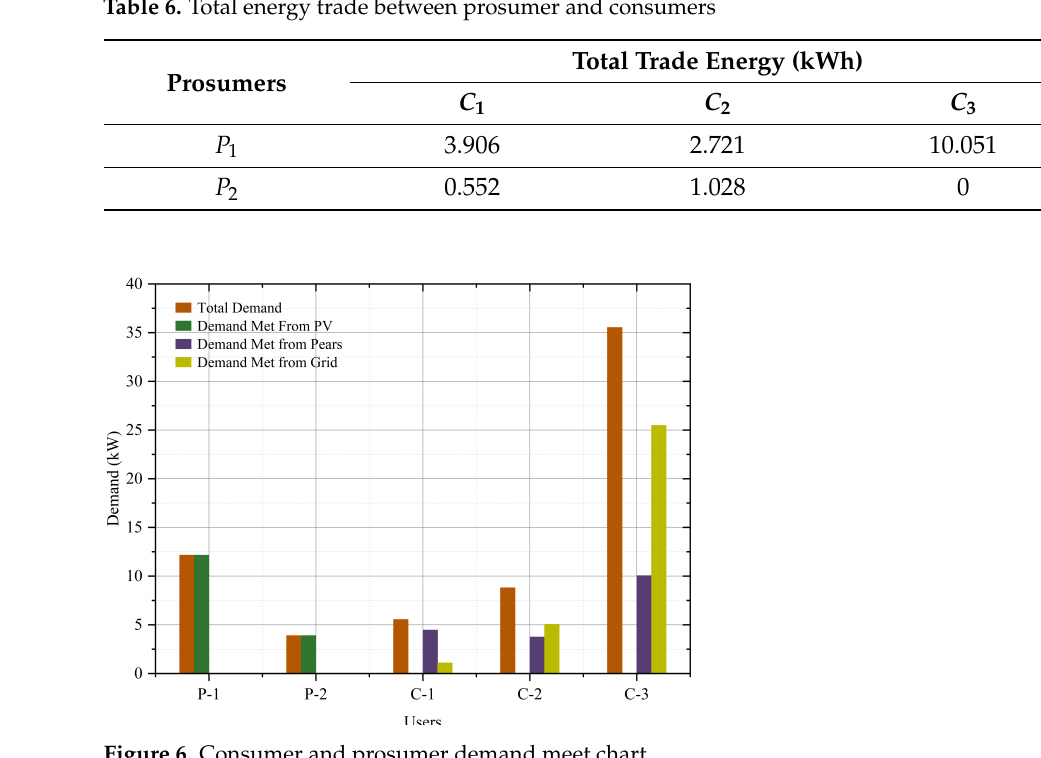
Figure 6. Consumer and prosumer demand meet